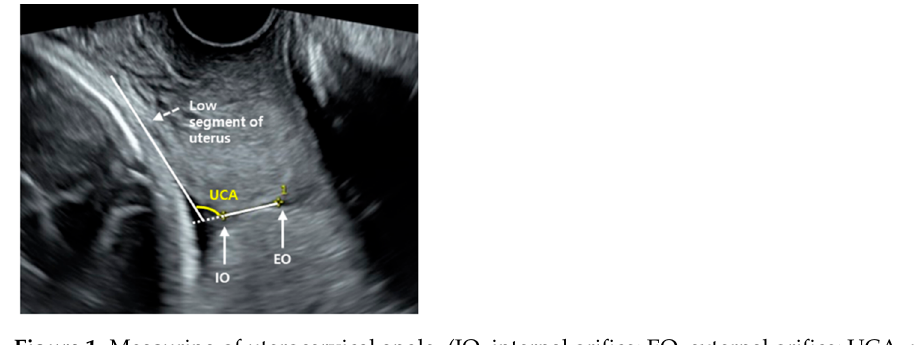
Figure 1. Measuring of uterocervical angle. (IO, internal orifice; EO, external orifice; UCA, uterocervical angle).